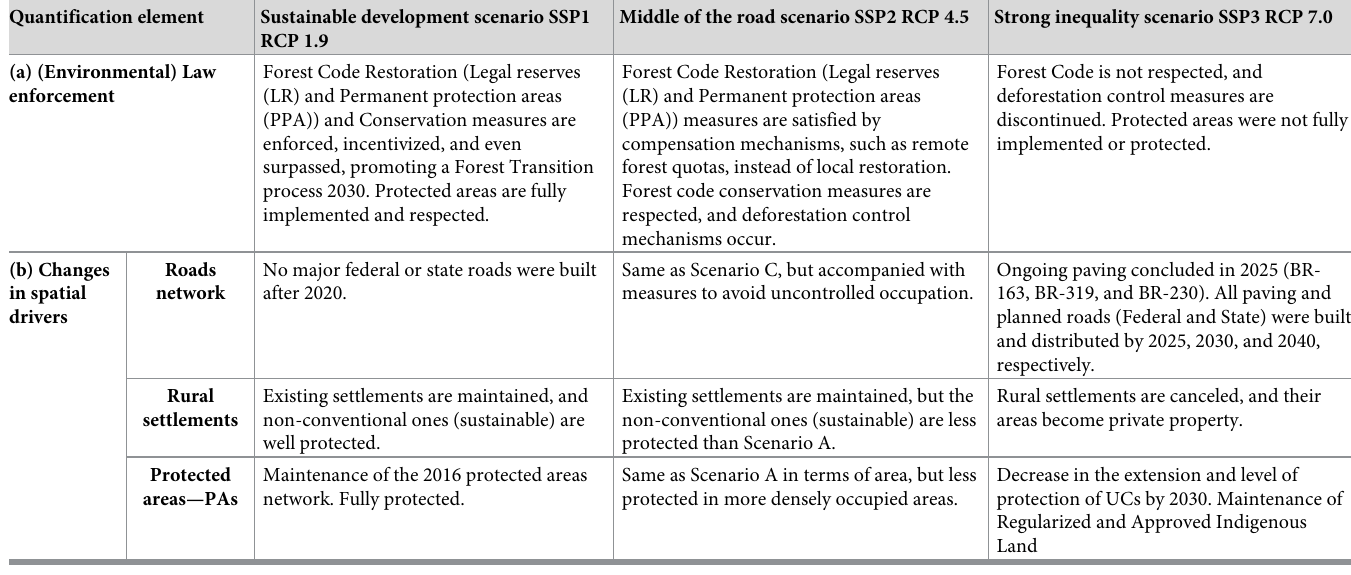
Table 3. Detailed regional assumptions related to Sustainable development scenario, middle of the road, and strong inequality scenario. Quantification